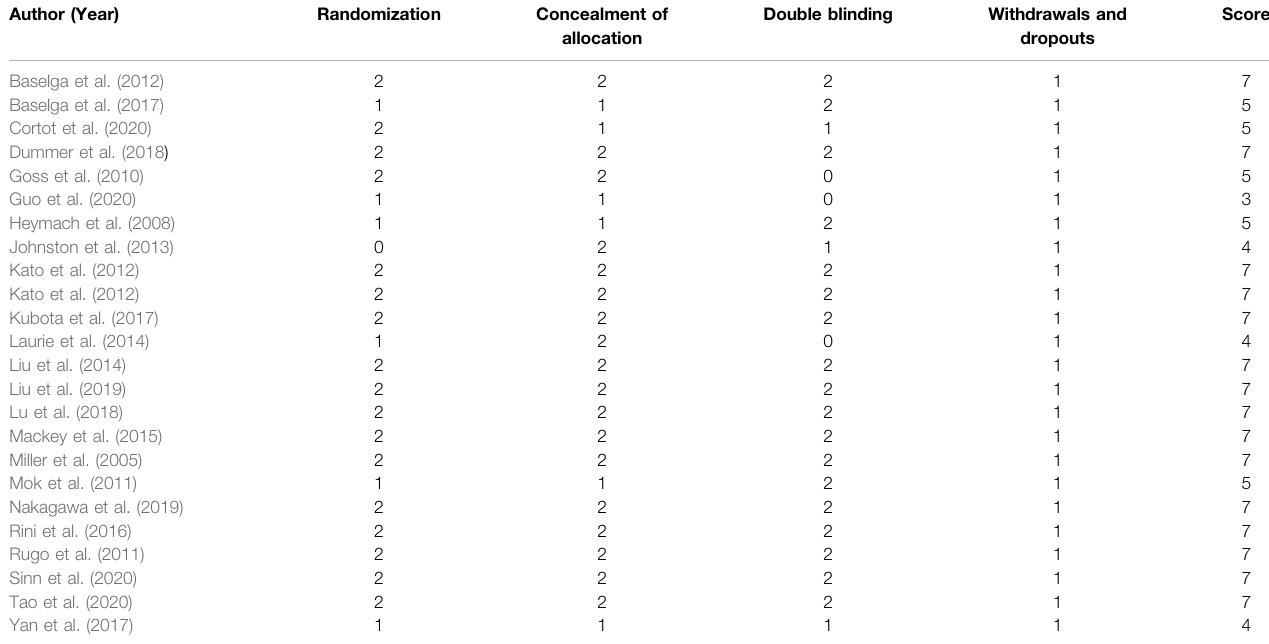
TABLE 3 | Scoring of modi fi ed Jadad measuring scale of the included